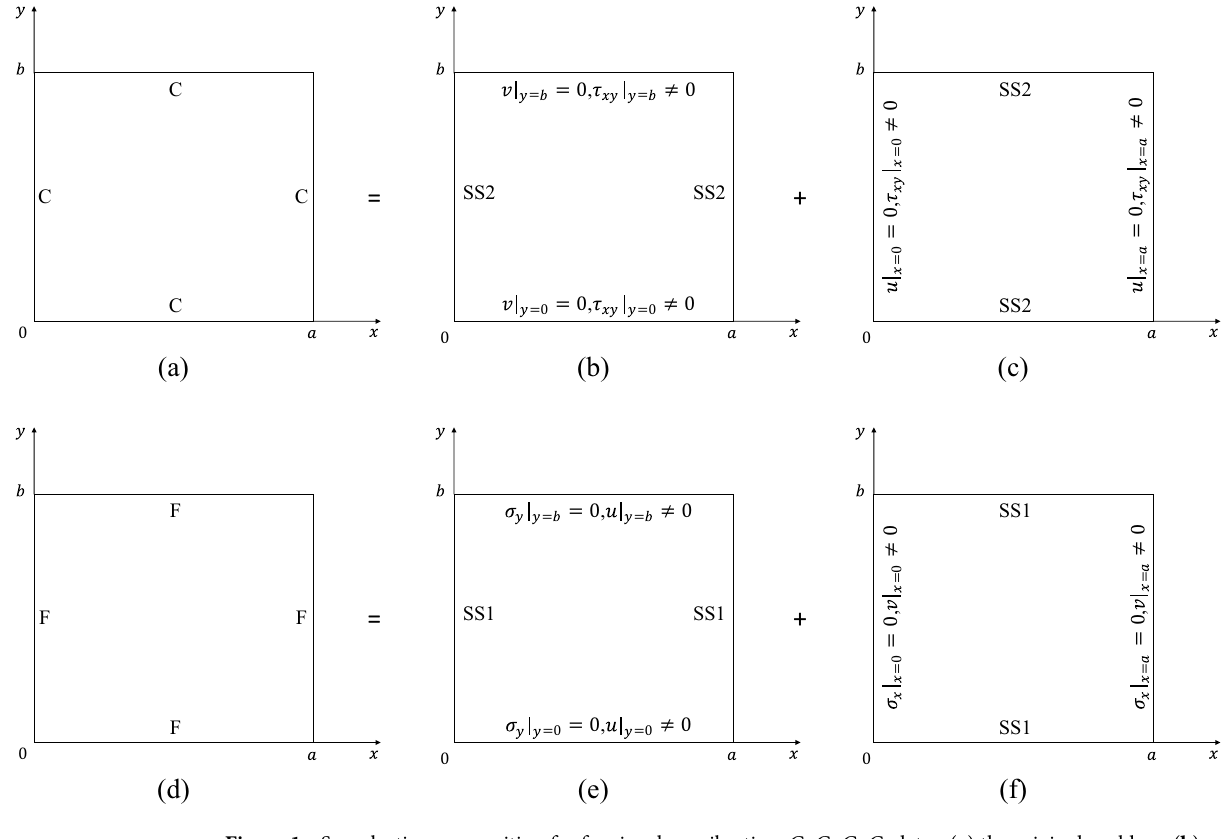
Figure 1. Symplectic superposition for free in-plane vibration. C–C–C–C plates: ( a ) the original problem, ( b ) the first elementary problem, and ( c ) the second elementary problem. F–F–F–F plates: ( d ) the original problem, ( e ) the first elementary problem, and ( f ) the second elementary